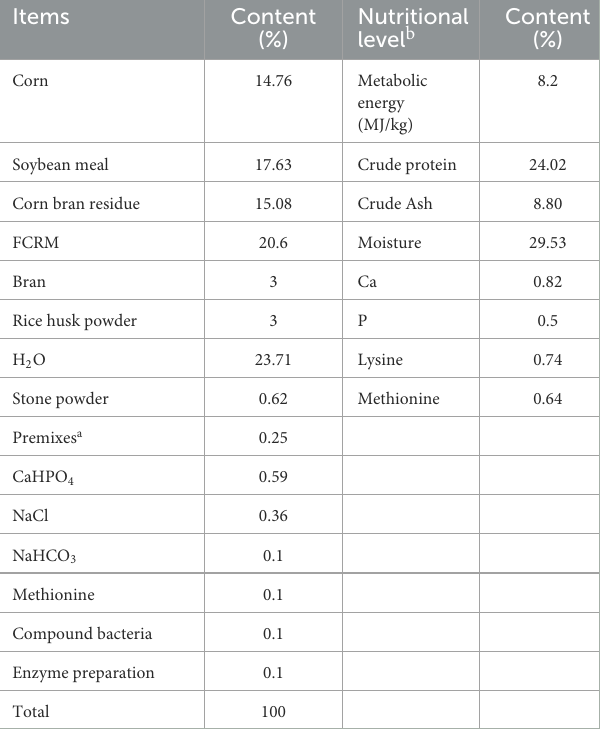
TABLE 2 The ingredient composition of FCMR and nutrient